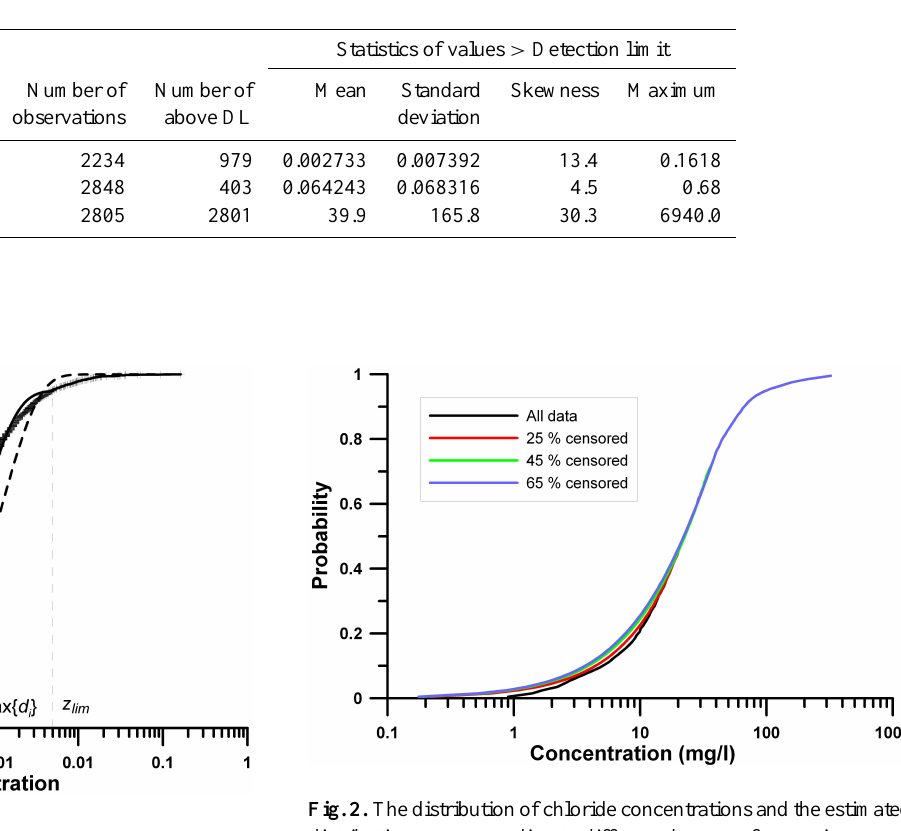
Table 1. Basic statistics of the investigated variables mean, standard deviation and skewness are calculated from values above the detection limit.